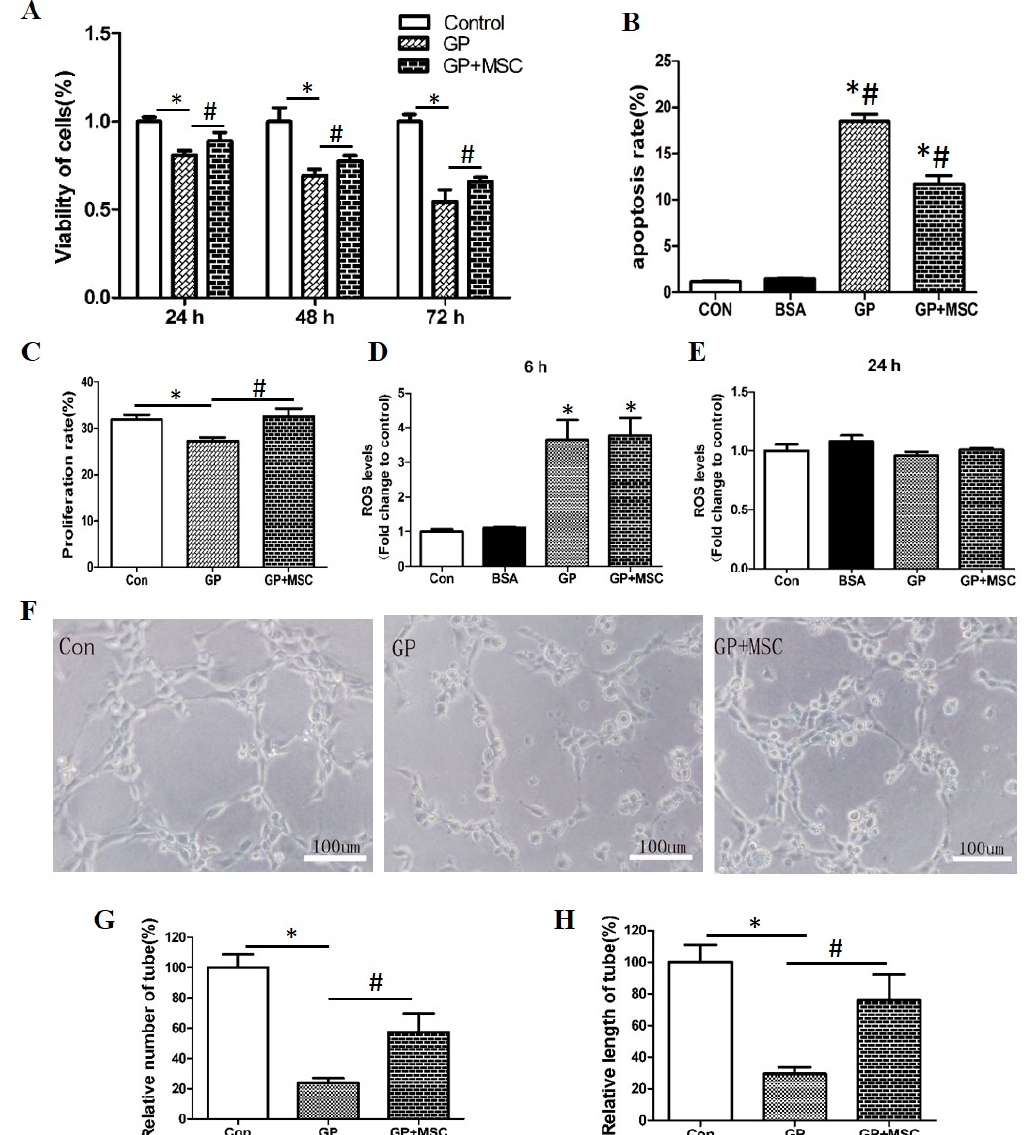
Figure 2. The protective effects of mesenchymal stem cells (MSCs) on GP treated HUVECs. 30 mM glucose plus 100 μ M palmitic acid (GP) were used to treat HUVECs with or without MSCs in Transwell system. ( A ) Time dependent cell viability; ( B ) Late stage cell apoptosis; ( C ) Cell proliferation rate was analyzed by cell cycle data. Proliferation rate = (S + G2/M)/(G0/G1 + S + G2/M) × 100%; ( D , E ) ROS levels after 6 or 24 h treatment; ( F ) Tube formation ability estimated by inverted light microscope (Scale bar = 100 μ m). The average number ( G ) and length ( H ) of complete capillary-like tubes formed by cells were calculated by Image-Pro Plus software. * p < 0.05 GP or GP + MSC versus control, # p < 0.05 GP versus GP + MSC.